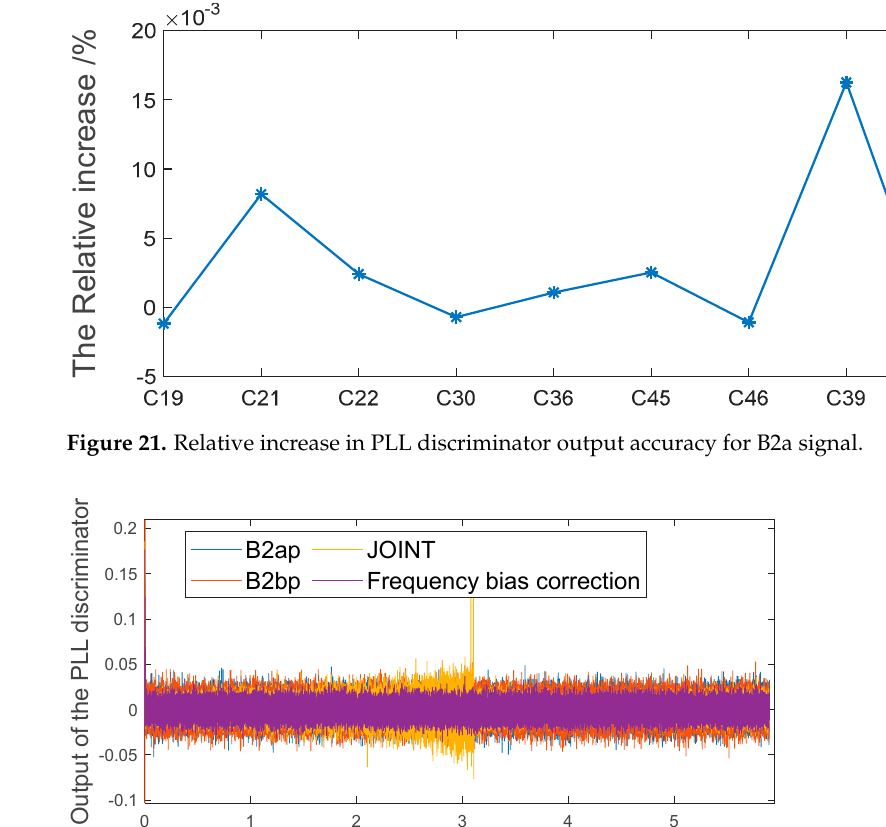
Figure 20. Relative increase in PLL discriminator output accuracy for MBOC signal.